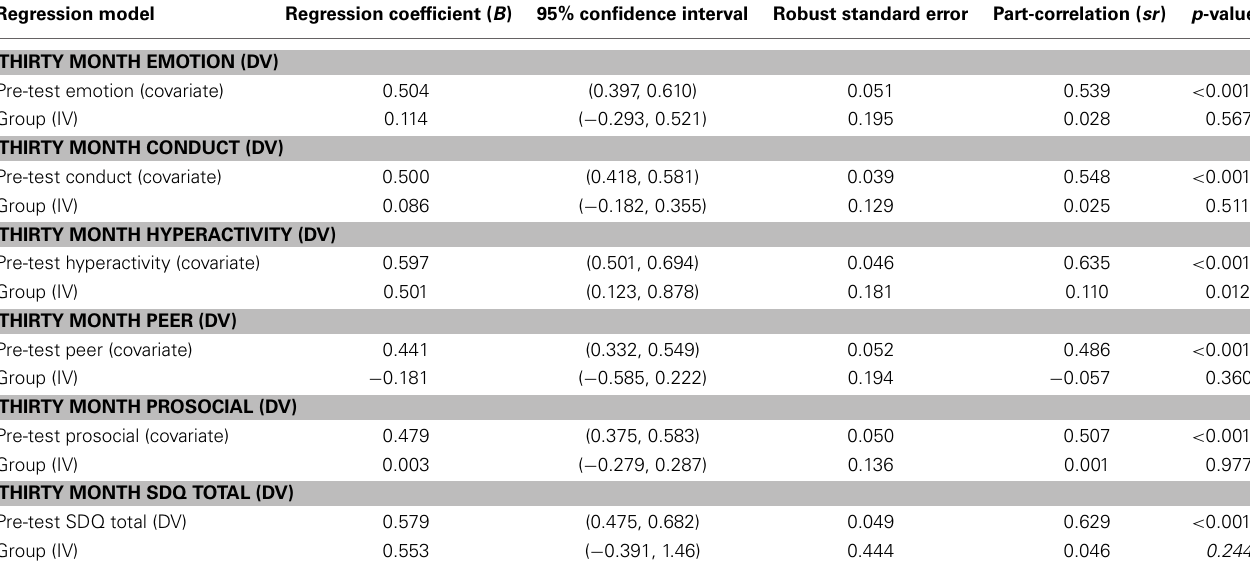
Table 4 | Results for regression analysis testing intervention effects on parent-reported outcomes (controlling for clustering in 22 schools). Regression